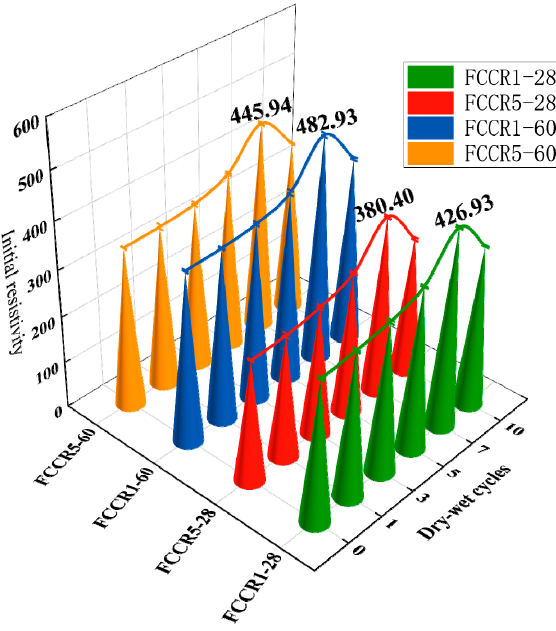
Figure 5. Curve of IR vs. different w-d cycles.